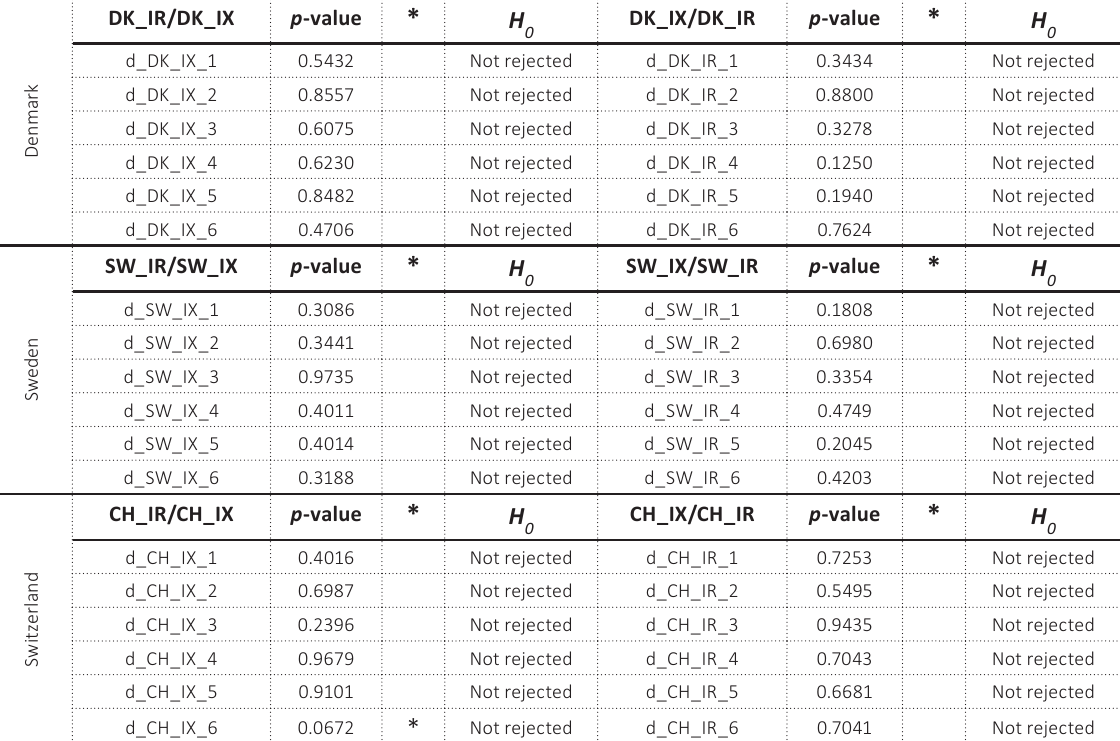
Source: Authors’ own work based on the results of